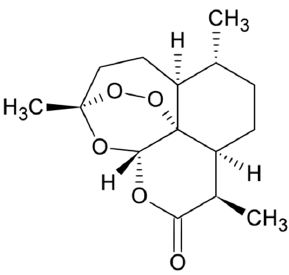
Figure 2. Structure of artemisinin.